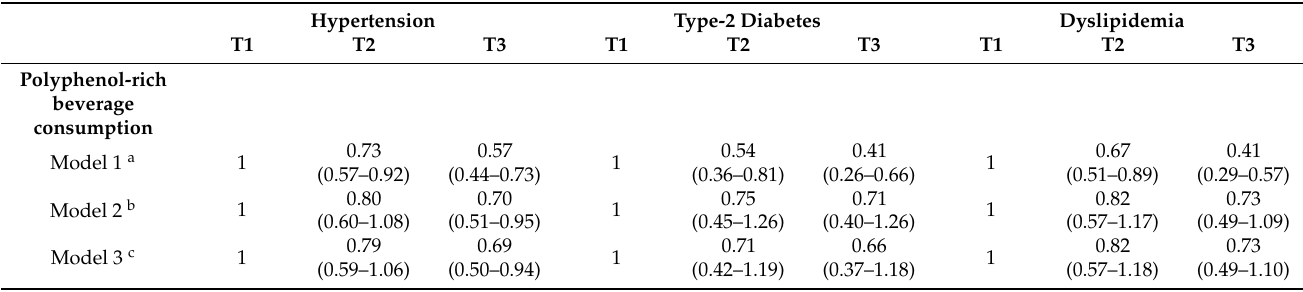
Table 8. Association between sample-level grouping by polyphenol-rich beverage consumption and metabolic outcomes.